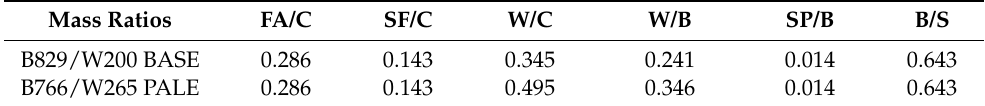
Table 3. Mass ratios of composition of concrete